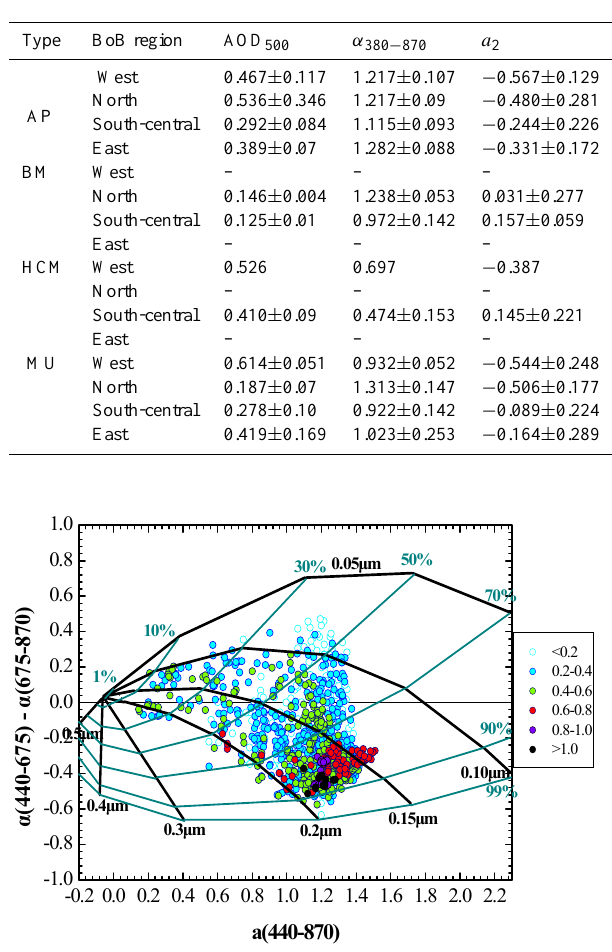
Table 1. Mean and standard deviations of AOD 500 , α 380 − 870 and coefficient a 2 values over the four BoB sub-regions corresponding to different aerosol types.